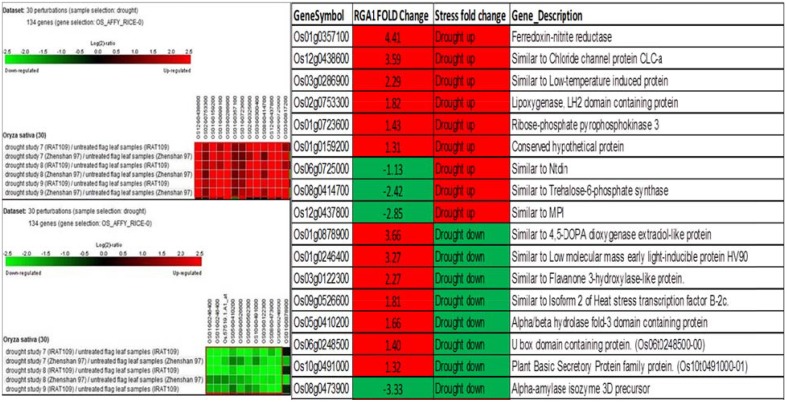
Expression profiles of 106 RGA1-regulated stress- responsive genes in drought stress (30 perturbations from literature). The red and green colors indicate up-regulation (log2 [2.5]) and down-regulation (log2 [−2.5]), respectively, as shown in the color bar. The expression data in the left panel were obtained using Genevestigator. The table compares their regulation in normal plants under stress in literature with actual fold-change values in the RGA1 mutant.